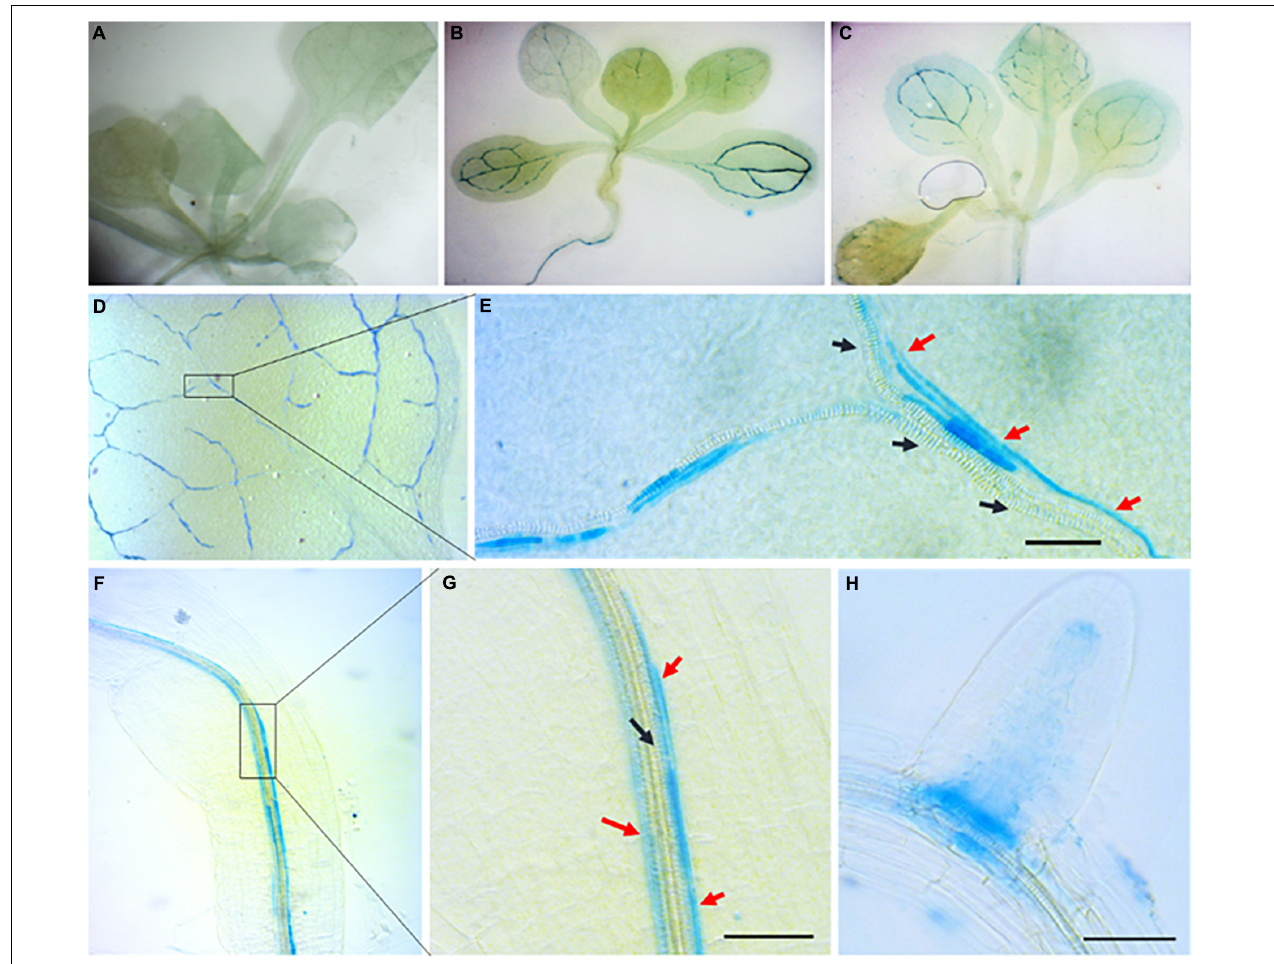
FIGURE 2 | Promoter activity of RabA2b during water stresses and ABA treatment. GUS histochemical staining of transgenic Arabidopsis plants expressing GUS gene driven by AtRabA2b putative promoter in Col-0 background 12-h after osmotic stress (400 mM sucrose) or 10 µ M ABA. The experiment was performed on 2 weeks old seedlings of five independent T3 homozygous lines. The representative images show plants under. (A) Control condition having no GUS staining, (B) sucrose induced osmotic stress with GUS expressing in leaves veins, and (C) 10 µ M ABA supplemented with 1/2 MS. In (D) we observe a leaf showing GUS activity in the vasculatures, while (E) is an enlarged image of a leaf showing unstained proto-xylem and GUS staining in conducting elements running parallel to the xylem, suspected as the phloem. GUS expression in the root is observed in (F) , in (G) , a higher magnification of the boxed area in (F) , and in (H) , in young root. The Black and Red arrow in (E,G) indicates proto-xylem and suspected phloem elements, respectively. Scale bar = 50 µ m. Similar results were obtained with 400 mM